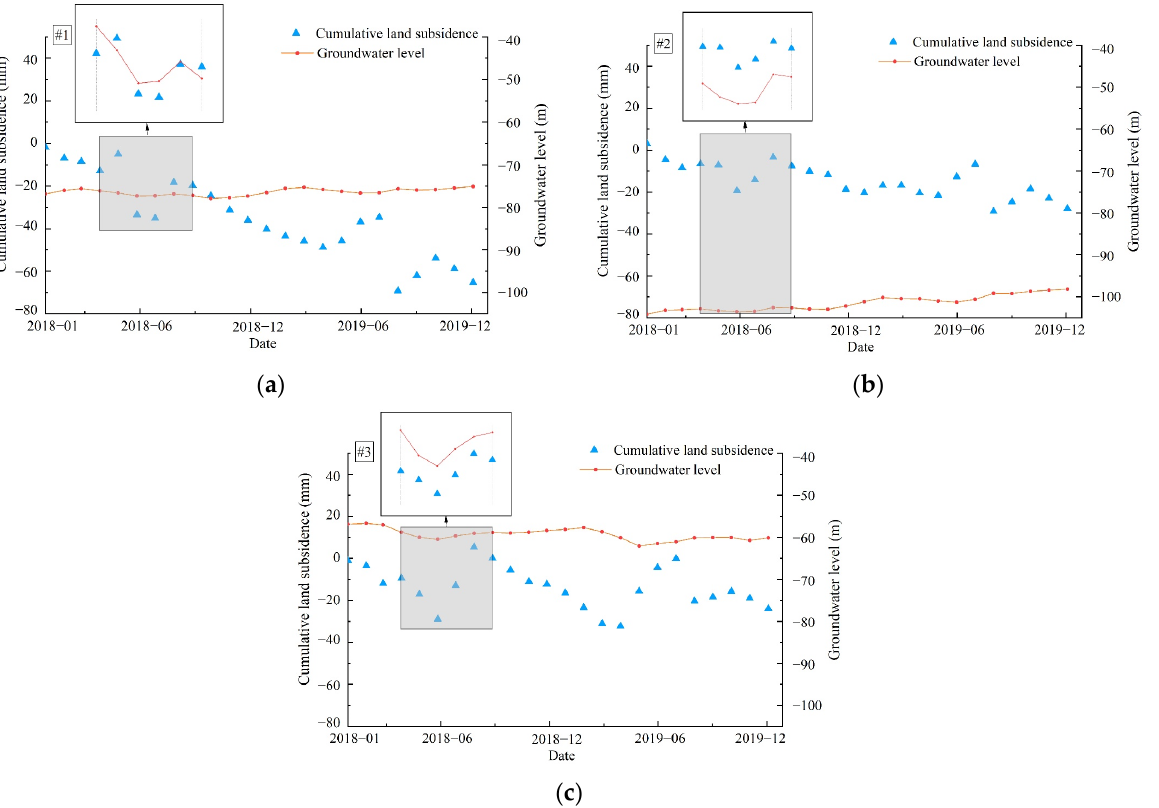
Figure 10. Cumulative land subsidence and groundwater level at typical groundwater monitoring wells: ( a ) well #1, ( b ) well #2 and ( c ) well #3.